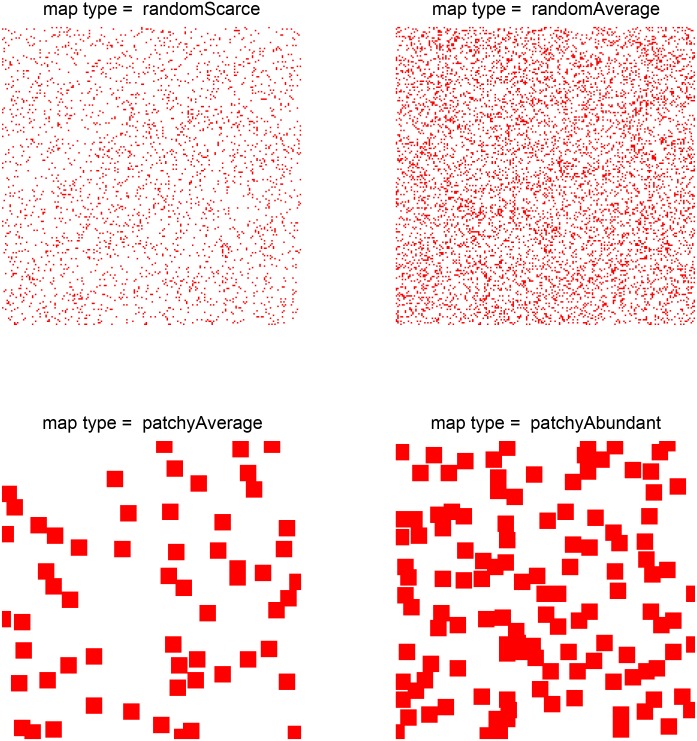
The simulations described in this paper were conducted for each of the four types of food distribution shown here: random scarce, random average, patchy average, and patchy abundant.